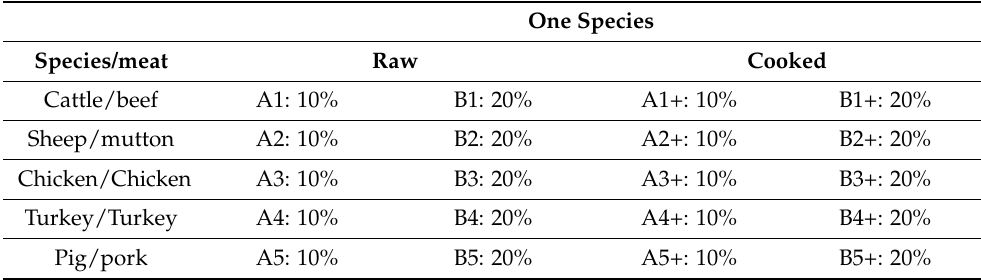
Table 1. Classification of minced meat samples obtained from five species.